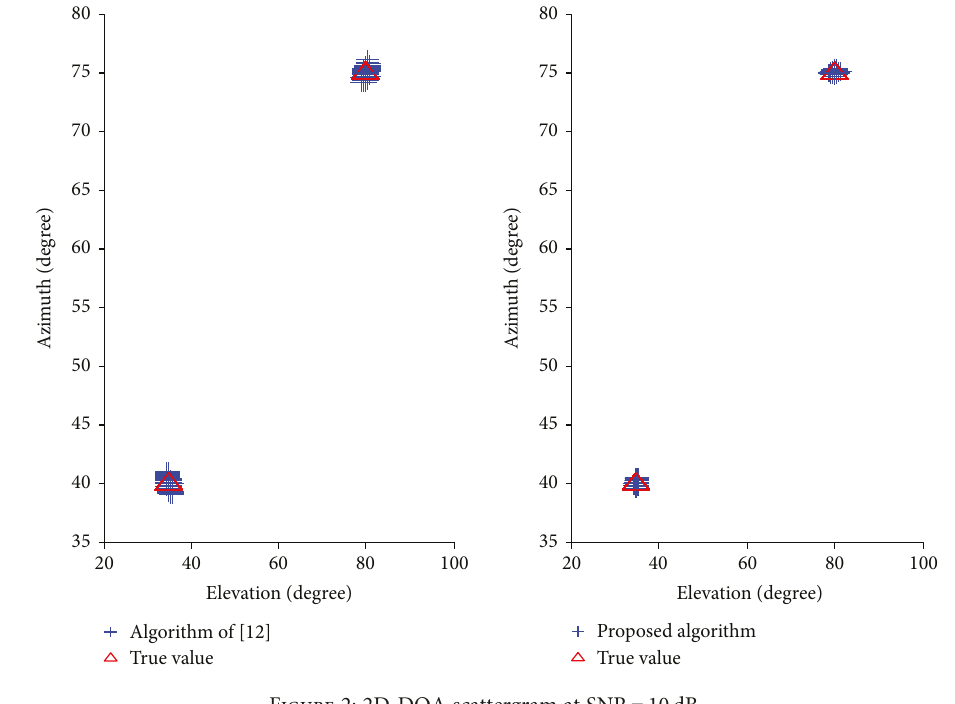
Figure 2: 2D-DOA scattergram at SNR=10 dB.